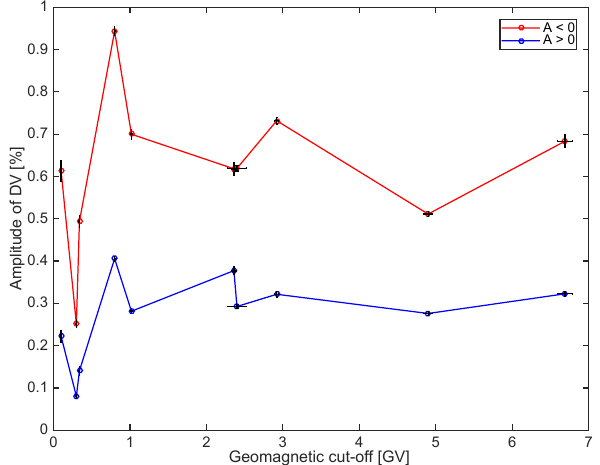
Figure 5. The difference in maximum/minimum time of the DV in neutron monitor count rates between polarity cycles, d τ , as a function of the neutron monitor’s geomagnetic cut-off rigidity, where d τ = τ A< 0 − τ A> 0 . The NMs shown (from left to right) are: South Pole ( R C = 0.1GV), McMurdo ( R C = 0.3GV), Thule ( R C = 0.3GV), Oulu ( R C = 0.8GV), Deep River ( R C = 1.02GV), Kiel ( R C = 2.36GV), Newark ( R C = 2.4GV), Climax ( R C = 2.92GV), Hermanus ( R C = 4.9GV) and Alma Ata ( R C = 6.69GV). The data are shown by the hexagons with x and y errors shown by the black crosses. Errors on the geomagnetic cut-off rigidities are calculated from the local variations in the geomagnetic field over the time span of the NM data, whereas the errors on d τ are calculated from the time taken for NM count rates plus their standard error to fall below the peak mean NM count rate value. The lines are best fits of the data, which are plotted just for reference. Thule is shifted slightly to the right to appear slightly apart from McMurdo.